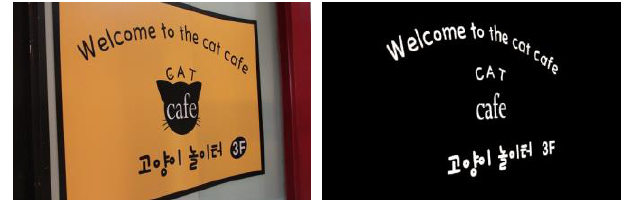
Figure 11. Example of test images and binary mask of ground